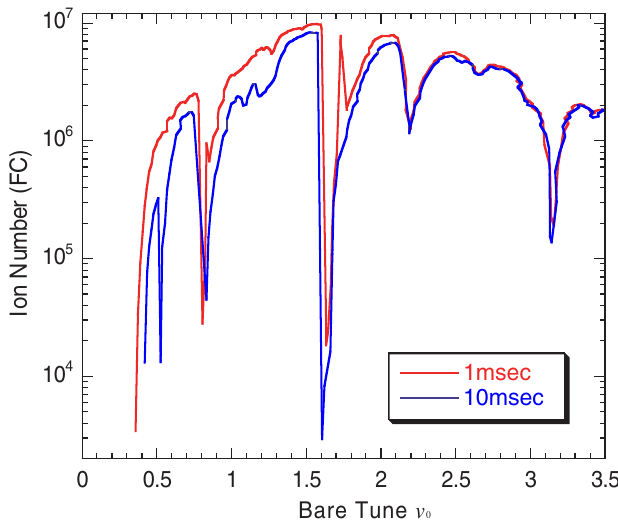
FIG. 11. (Color) Experimental results in the N sp ¼ 3 (1%) plus ¼ 1 (0.5%) case presented in Fig. 10 contrasted for 1 and N sp 10 msec plasma storage times.